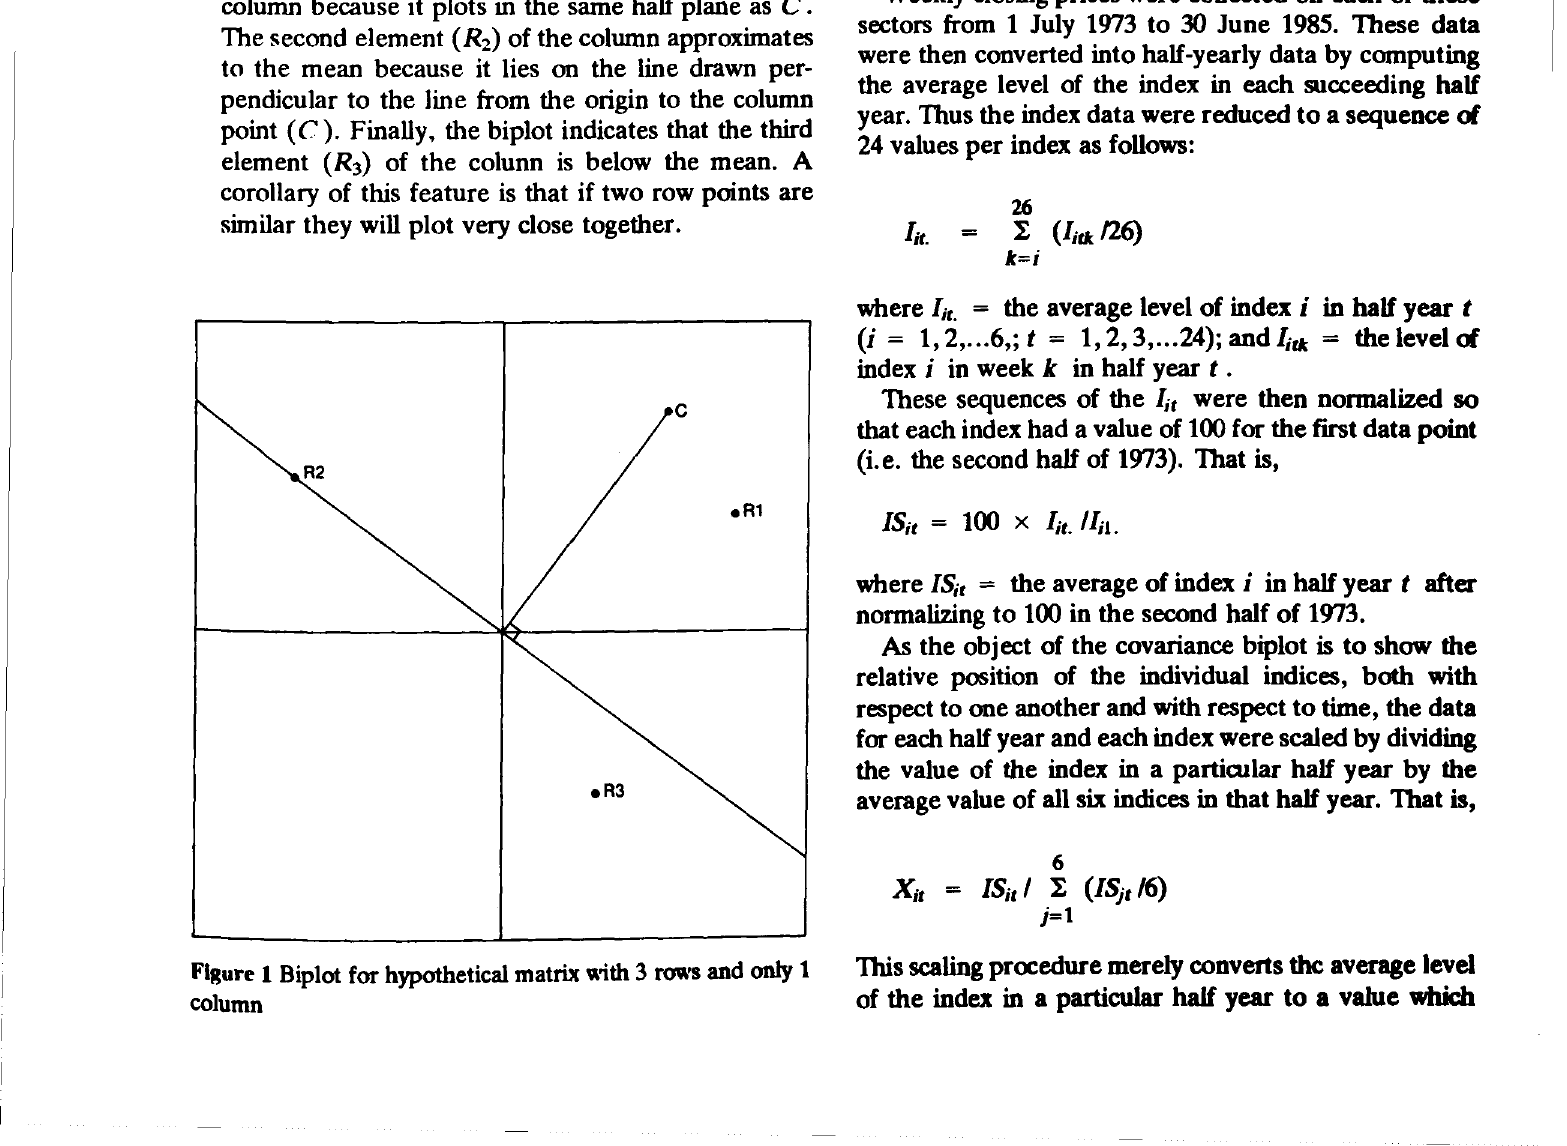
Figure 1 Biplot for hypothetical matrix \\'ith 3 l'O\\'S and only 1